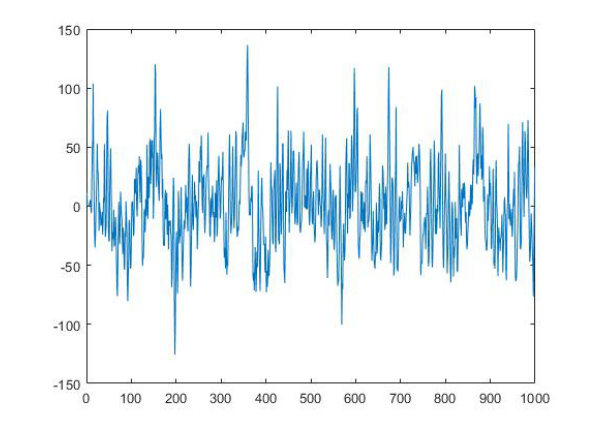
Figure 10. chb02-03 OWA Output